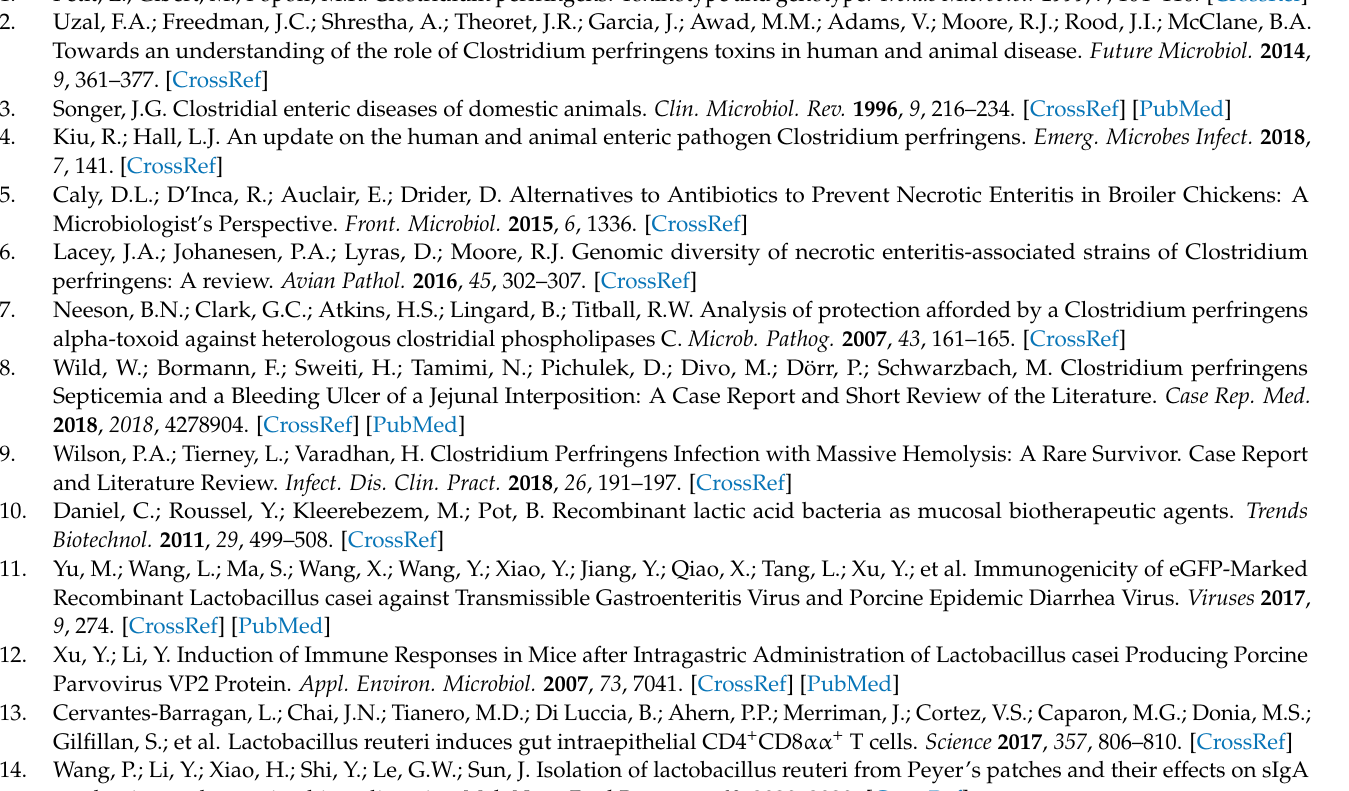
Figure S2: Expression of the protein of interest identified by western blot detection with anti- α toxin polyclonal